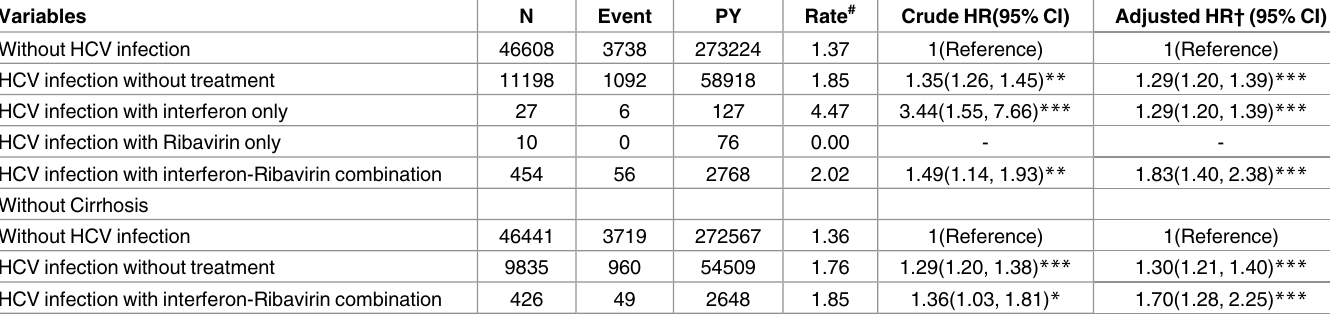
Table 5 showed that synergistic effects of HCV with diabetes, hyperlipidemia, and alcohol- related illness on the risk of cataract. Diabetic HCV patients had increasing risk of cataract (aHR = 1.69, 95% CI = 1.48–1.93), compared with non-HCV and non-diabetic patients. HCV patients with accompanying hyperlipidemia had 1.67-fold higher risk of cataract, compared with non-HCV and non-hyperlipidemia patients. Discussion In this population-based cohort study, we observed that HCV infection, even in the absence of cirrhosis, was associated with an increased risk of cataract. HCV-infected patients receiving interferon–ribavirin therapy had a 1.83 times higher risk of cataract compared with those with- out HCV infection and not receiving interferon–ribavirin therapy. This suggested that all Table 4. Incidence, and hazard ratio of cataractbetween patients with HCV infection with and without treatment.